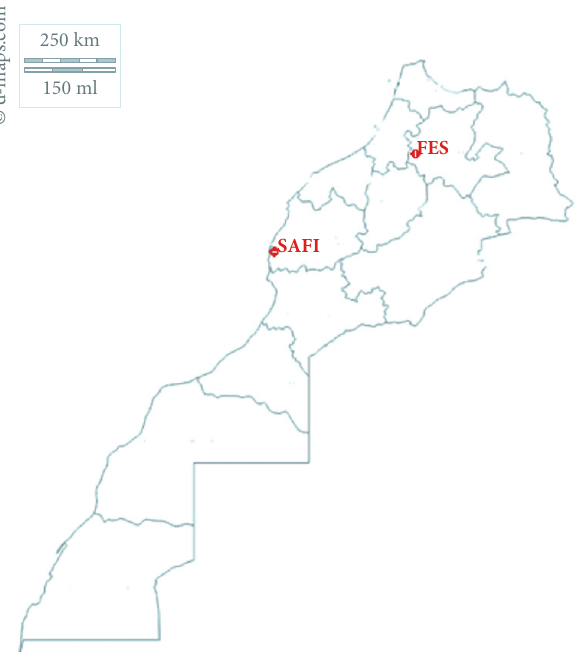
Figure 1: Geographic location of the tow harvested samples of Capparis spinosa